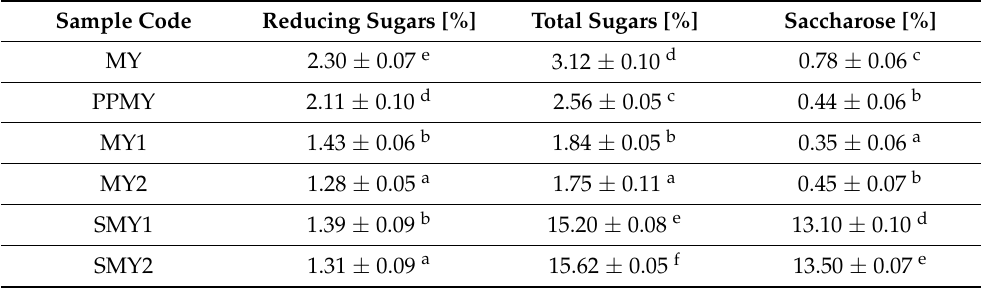
Table 4. Changes in the total sugars content, reducing sugars during fermentation and frozen desserts manufacture (cultivar “ Melon Yellow ” of the Cucurbita maxima